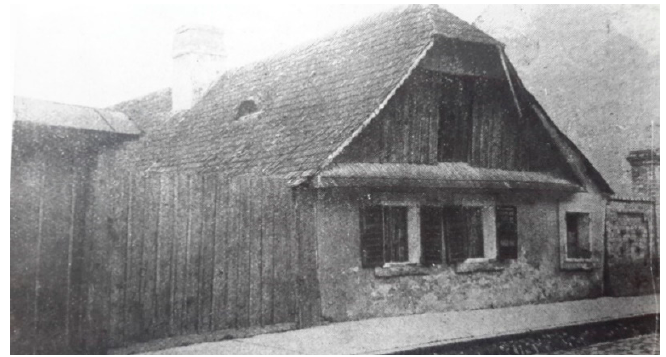
Figure 11. The Herzl family House in Zemun, once Apostelgasse 253, before 1910.